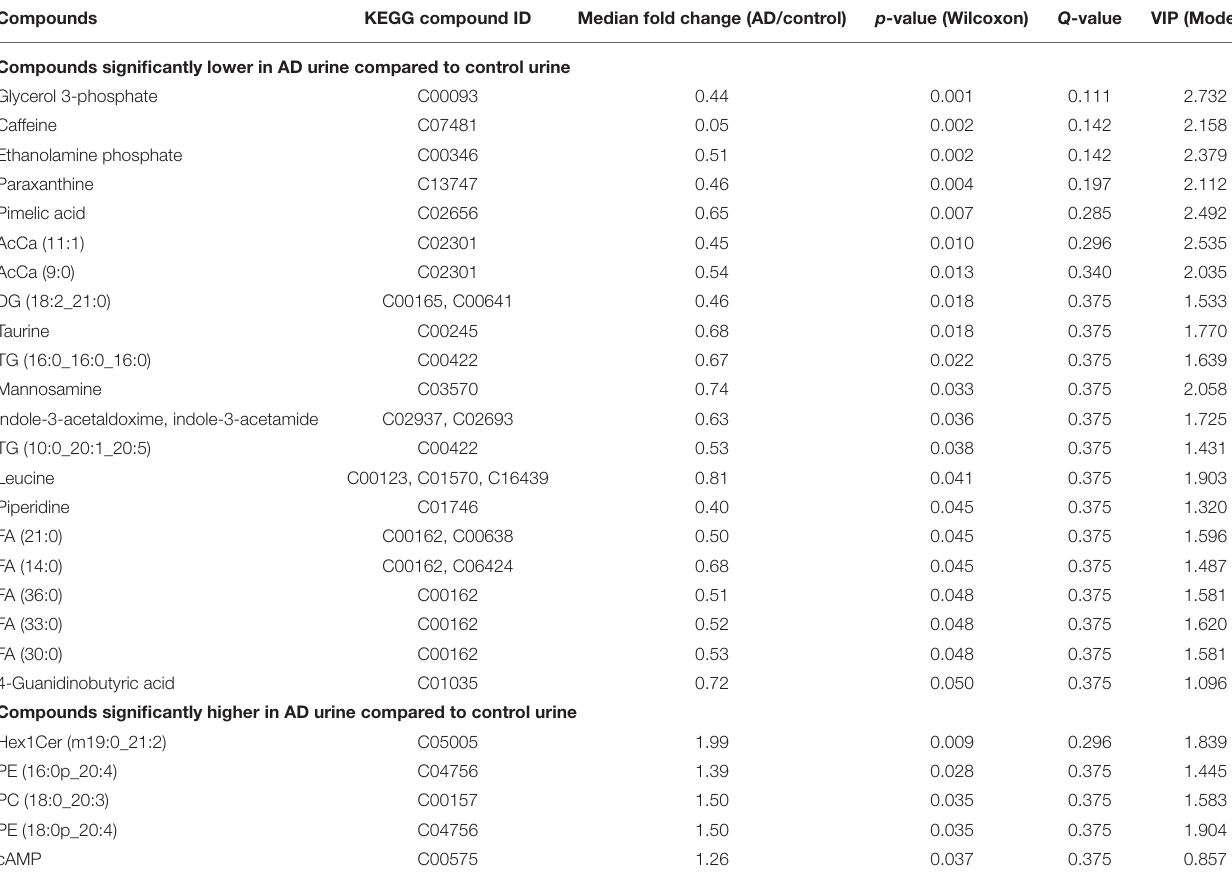
TABLE 1 | Correlation coefficients for SC thickness values calculated by five different methods. Compounds KEGG compound ID Median fold change (AD/control) p -value (Wilcoxon) Q -value VIP (Model 1) Compounds significantly lower in AD urine compared to control urine Glycerol